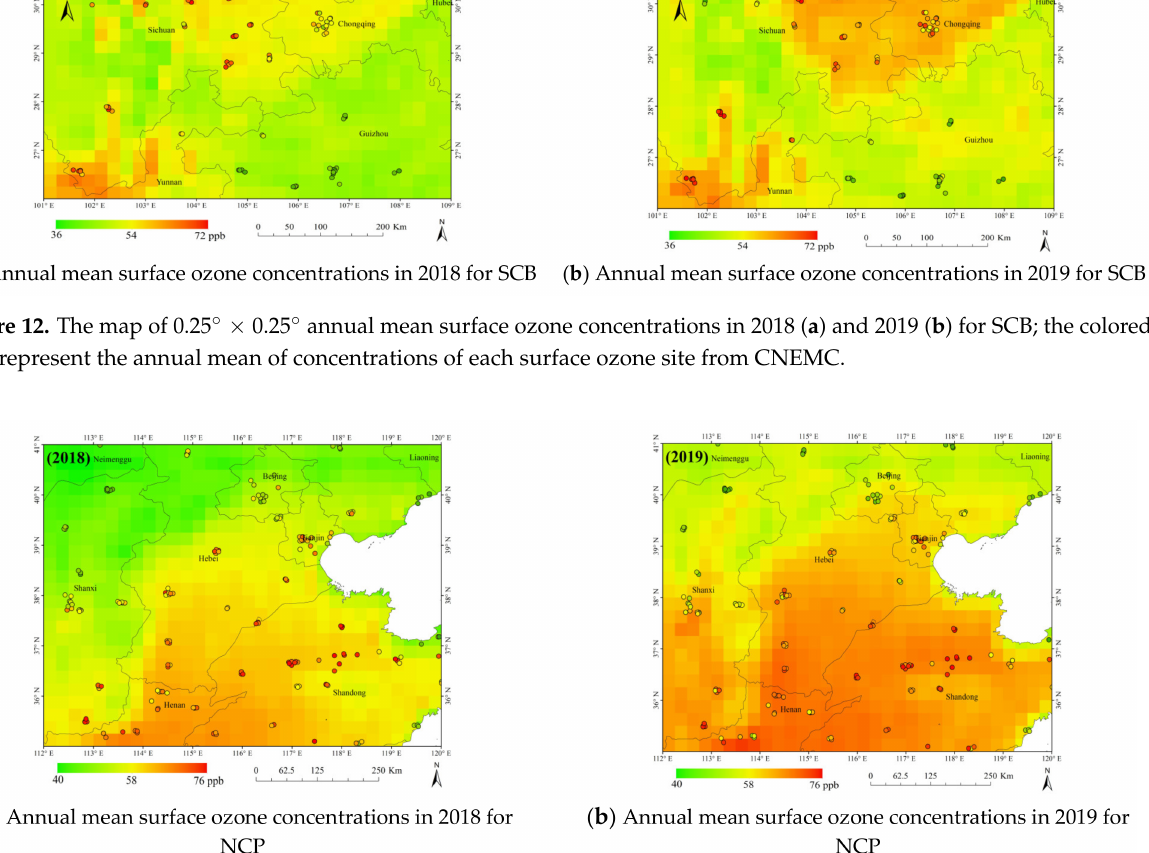
Figure 13. The map of 0.25 ◦ × 0.25 ◦ annual mean surface ozone concentrations in 2018 ( a ) and 2019 ( b ) for NCP; the colored dots represent the annual mean of concentrations of each surface ozone site from